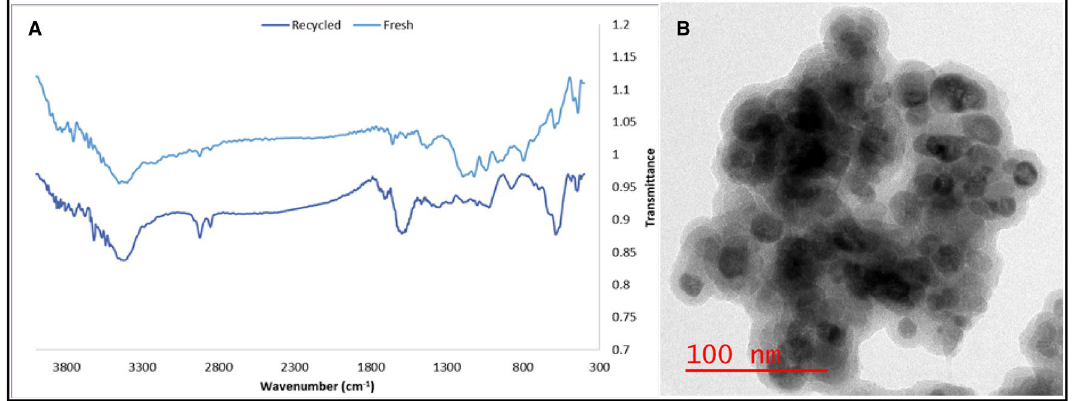
Figure 3. The FTIR spectra (A) of fresh and recycled Pd@h-Fe 2 O 3 @C catalyst and TEM image (B) of the recycled catalyst after five